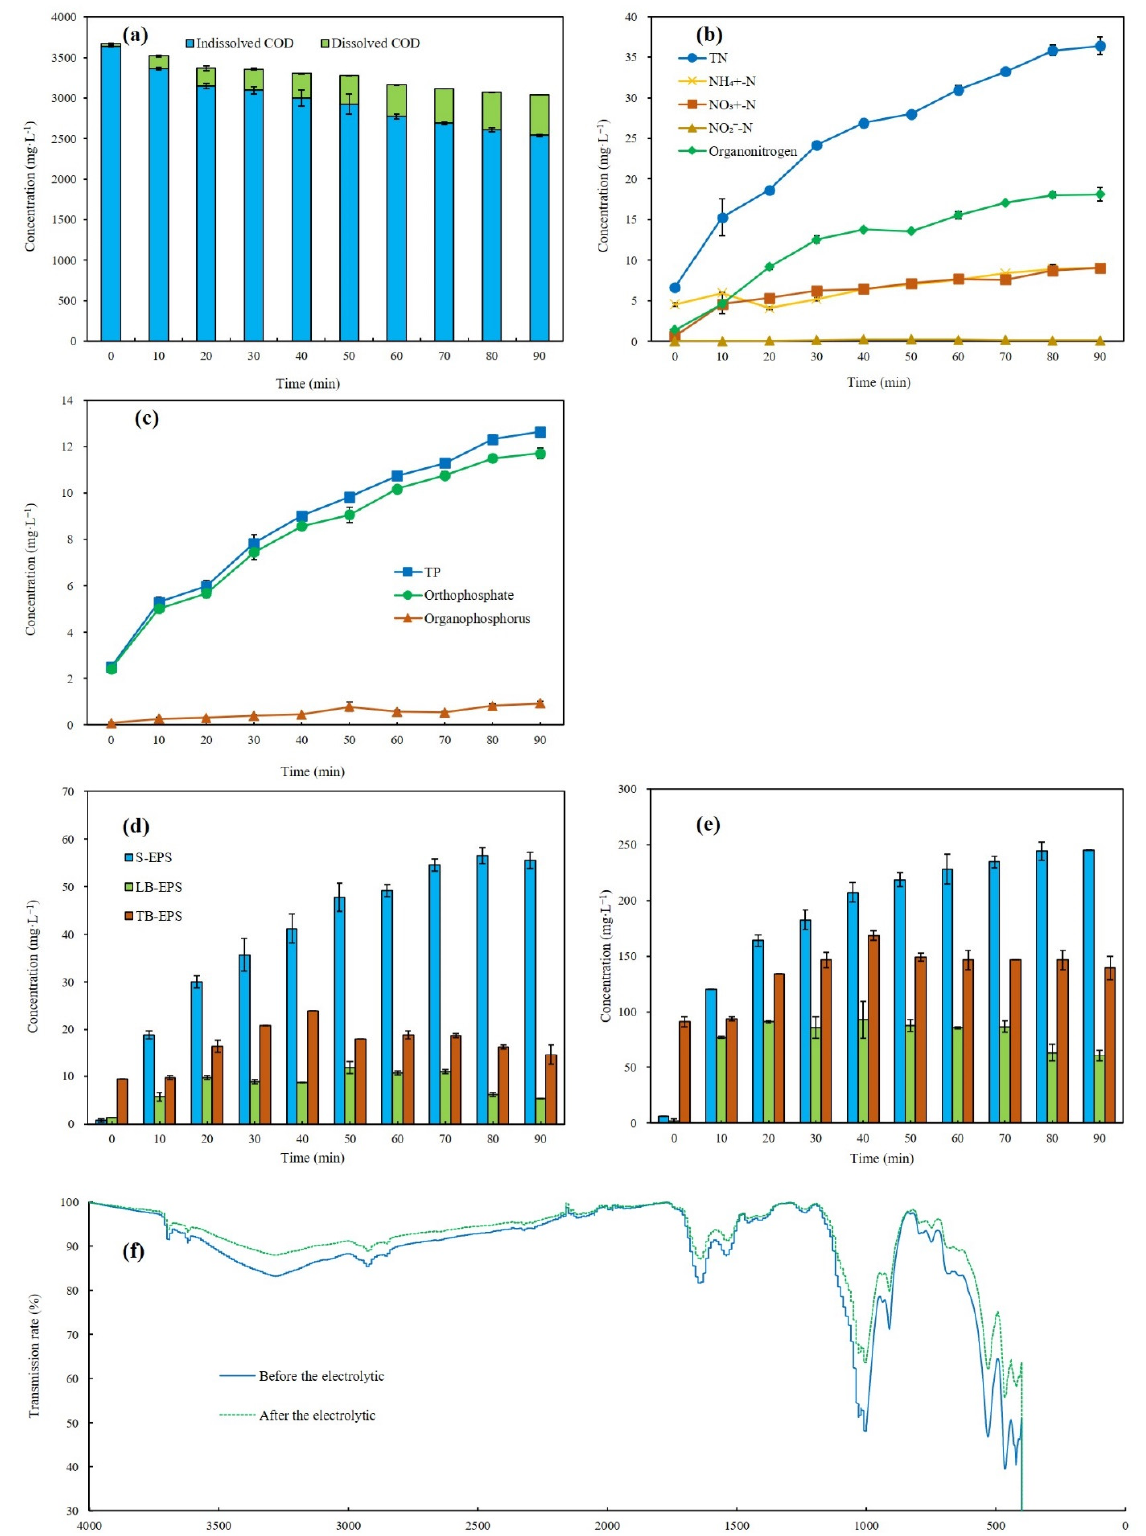
Figure 6. Changes in the concentrations of ( a ) Different types of chemical oxygen demand (COD), ( b ) Different types of nitrogen, ( c ) Different types of phosphorus, ( d ) Protein, ( e ) Polysaccharide, and ( f ) An Fourier transform infrared spectrometer (FTIR) image of sludge extracellular polymeric substances (EPS) level before and after